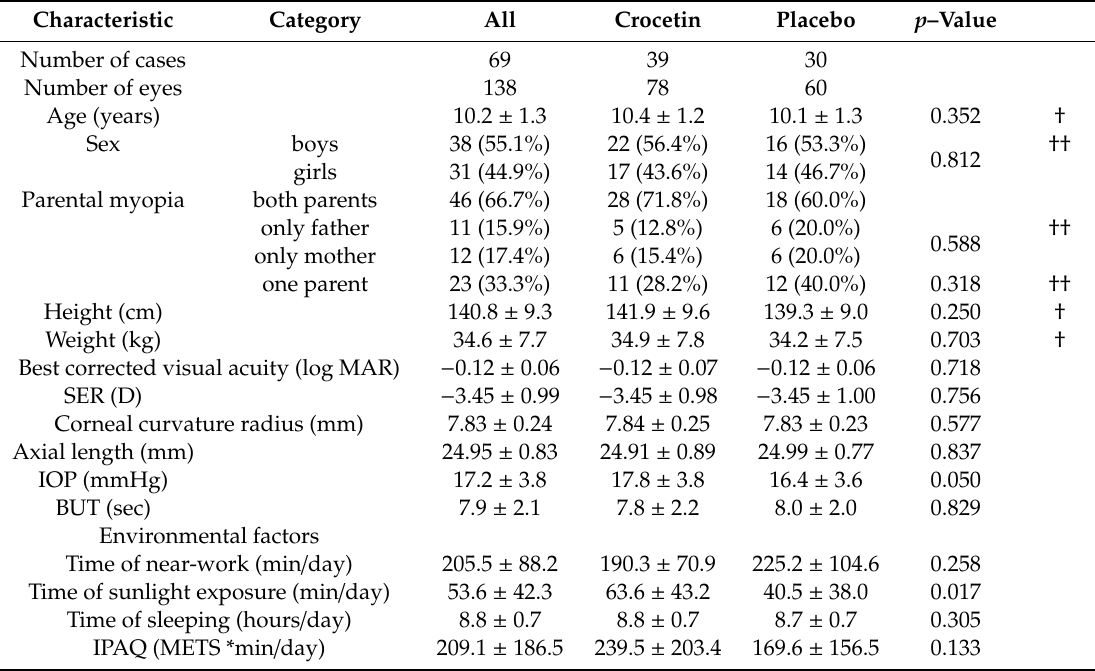
Table 1. Characteristics of the 138 eyes of 69